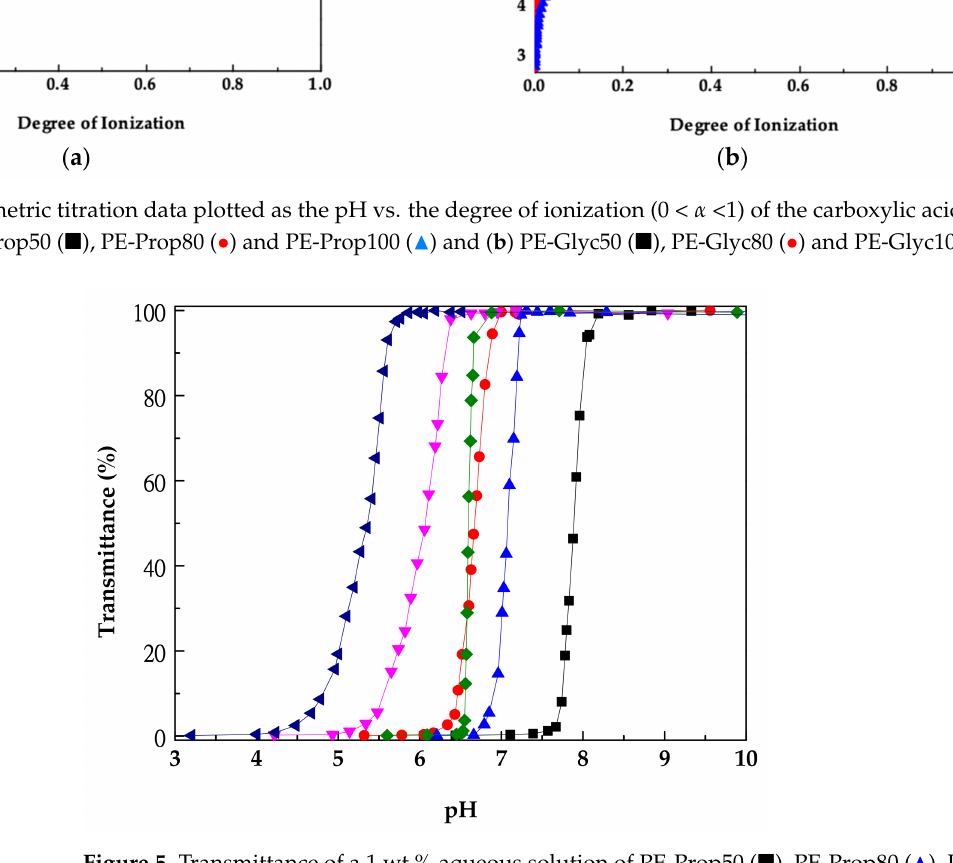
Figure 5. Transmittance of a 1 wt.% aqueous solution of PE-Prop50 ( (cid:4) ), PE-Prop80 ( (cid:78) ), PE-Prop100 ( (cid:7) ), PE-Glyc50 ( • ), PE-Glyc80 ( (cid:72) ) and PE-Glyc100 ( ) as a function of the solution pH. PE-Prop50, exhibited a sharp transition in its transmittance at pH = 8.1, indicating Table 1. Functional polyesters and their characterization that the polymer is soluble at high pH values and becomes hydrophobic below this pH.